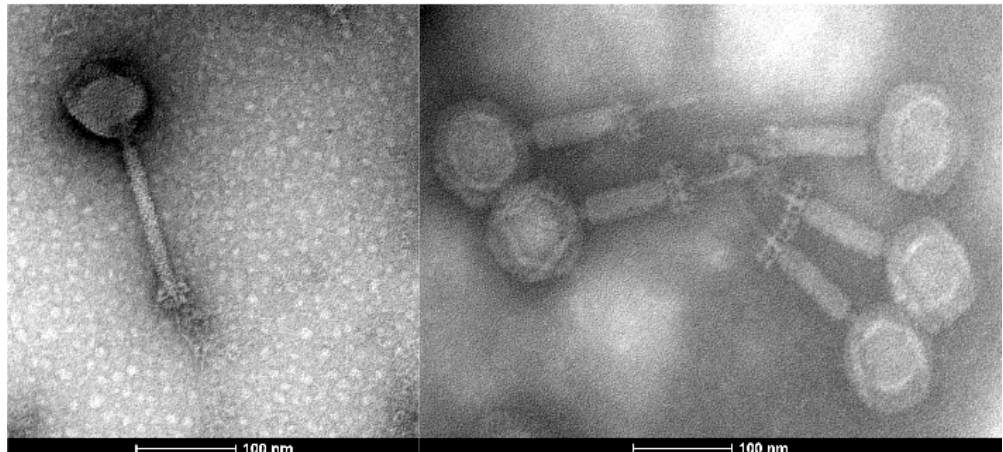
Figure 1. Electron micrograph of Enterococcus phage A2. Phage particles were negatively stained with / v ) uranyl acetate. Scale bar represents 100 0.5% ( w / v ) uranyl acetate. Scale bar represents 100 nm. 0.5% ( w